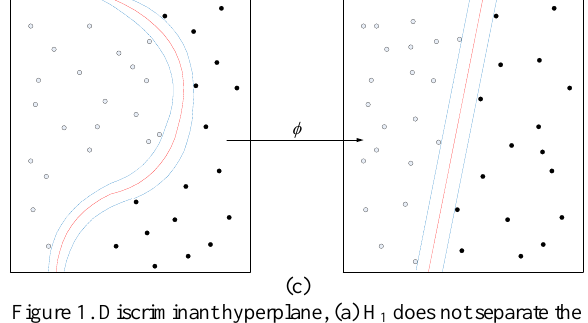
Figure 1. Discriminant hyperplane, (a) H 1 does not separate the classes, H 2 does, but only with a small margin, H 3 separates them with the maximum margin. (b) Maxinum-margin hyperplane and margins for an SVM trained with samples from two classes, samples on the margin are called the support vectors. (c) Kernel machine for nonlinear